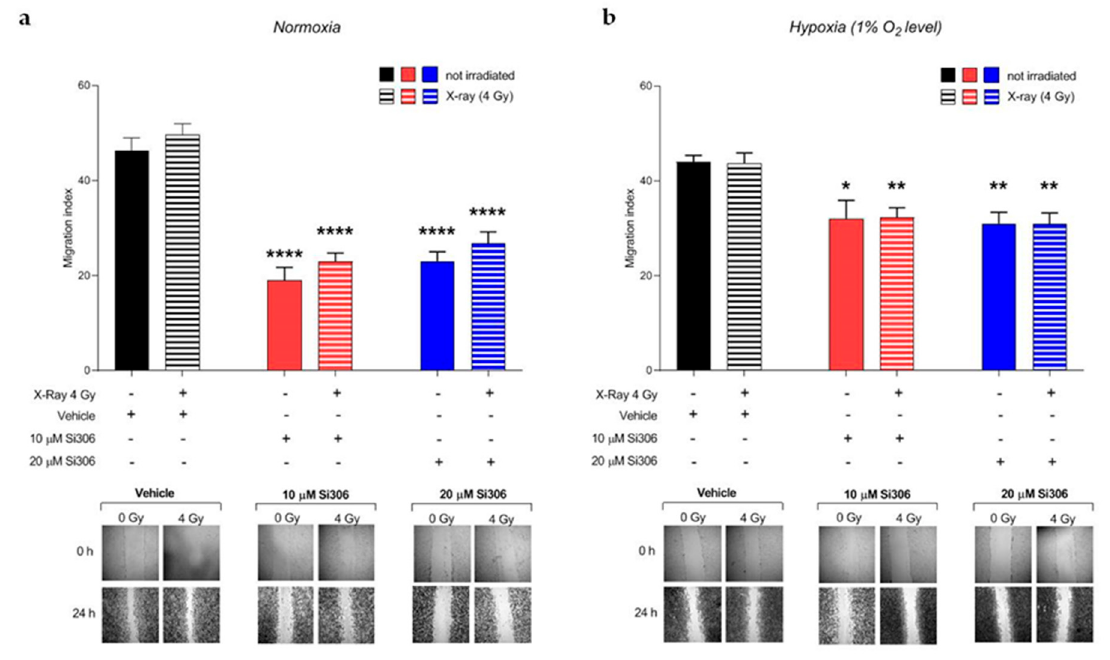
Figure 9. Effects of Si306 on migration of U251-MG cells in normoxia (a) and hypoxia (b) . Data are mean ± SEM of n = 3 independent experiments. * p -value < 0.05, ** p -value < 0.01 and **** p -value < 0.0001 versus vehicle or vehicle + irradiation at 24 h after scratch (F normoxia = 32.59, p -value < 0.0001; F hypoxia = 6.907, p -value < 0.0001. One-way ANOVA with Holm–Šídák post-hoc test).